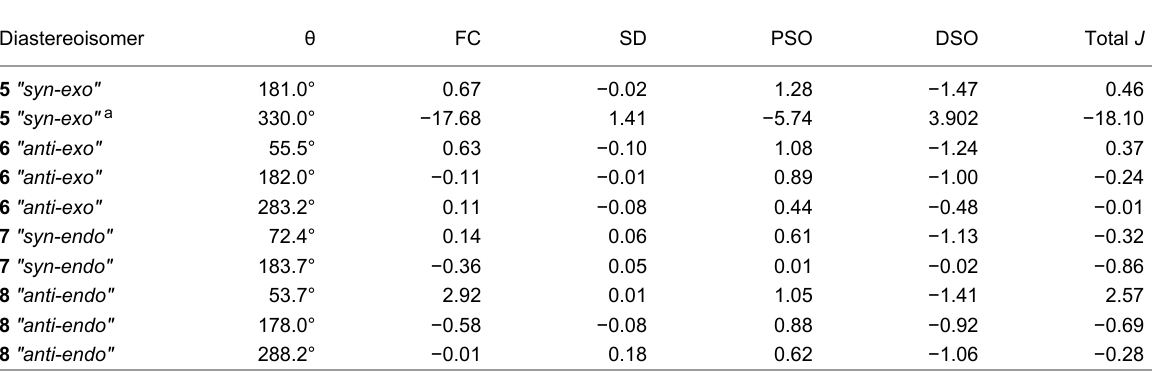
Table 3: Calculated F,H(O) SSCC for 5 – 8 , and the corresponding terms contributing to the overall J (FC, Fermi contact; SD, spin dipolar; PSO, para- magnetic spin-orbit; DSO, diamagnetic spin-orbit), in hertz.